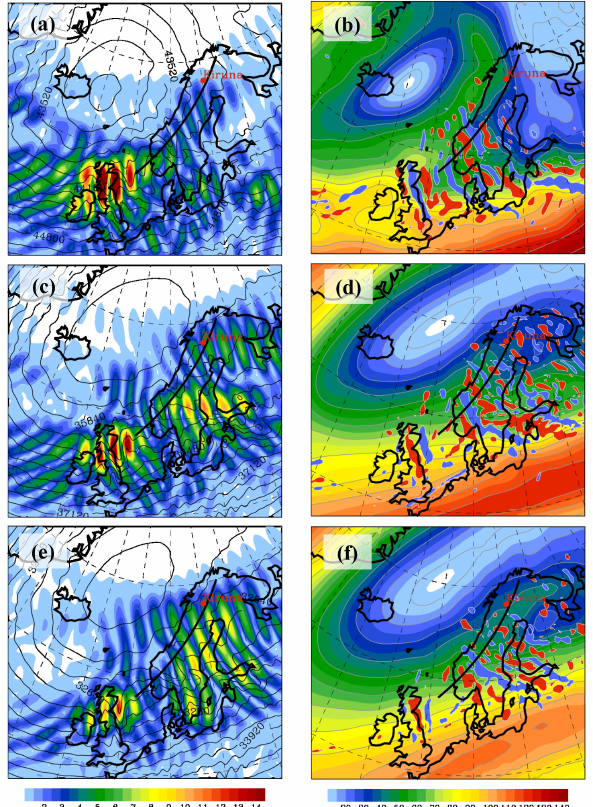
(ms − 1 , Figure 5. Same as Fig. 4 for 12:00UTC on 30 January 2016. H indicates downward-propagating waves in an extended H